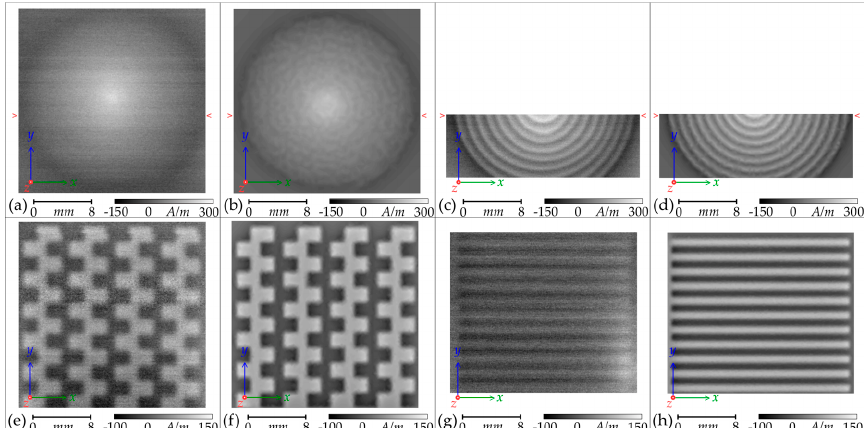
Figure 6. Greyscale maps of the H ( z ) amplitudes of three of the manufactured planar coils, energized to draw 0.40 A ± 0.01 A and scanned at the heights presented in Table 1, alongside the equivalent maps calculated by ANSYS ® finite-element modelling: ( a – d ) Circular planar coil; ( e , f ) Mesh planar coil; ( g , h ) Meander planar coil. The transect marked by red single-chevrons indicates the path of the two H ( z ) amplitude plots presented in Figure 8.